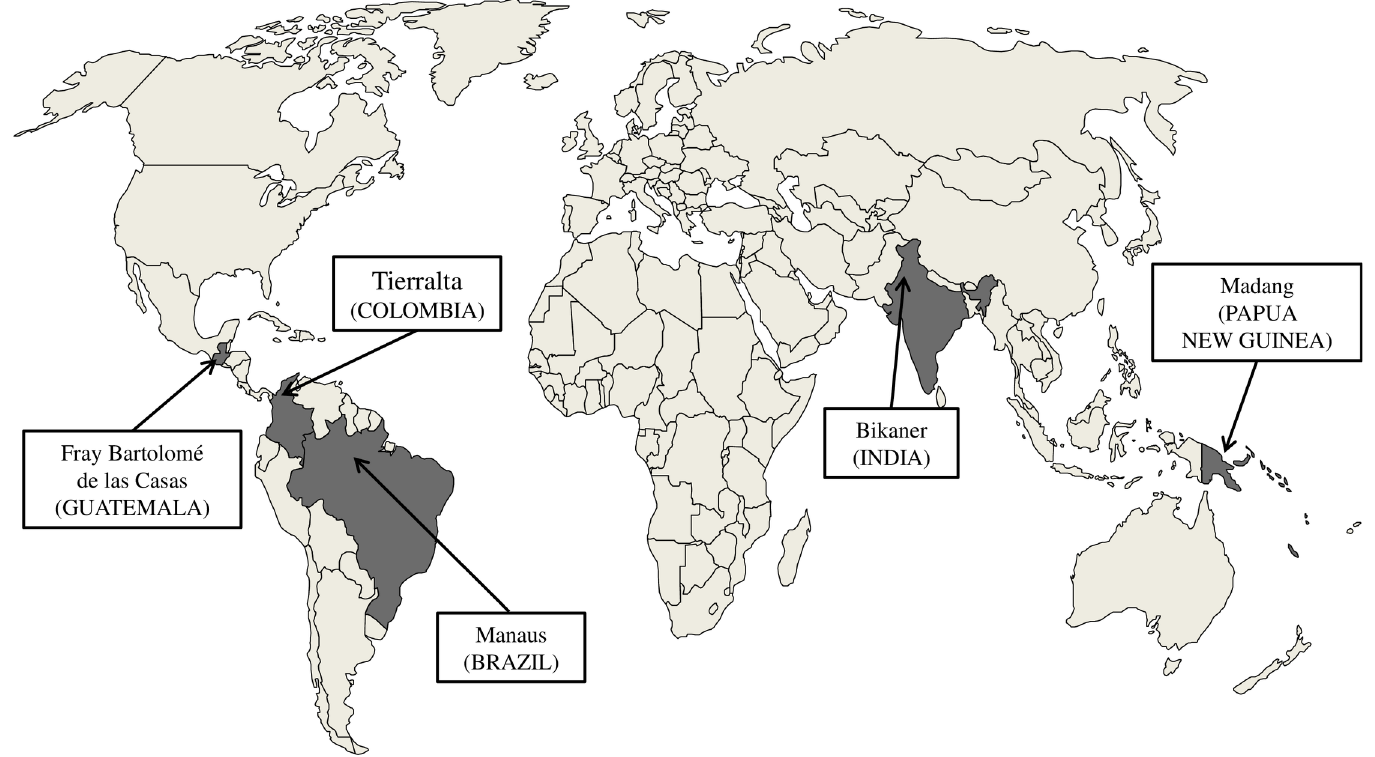
Fig 1. Map of the five endemic study areas that participated in the PregVax